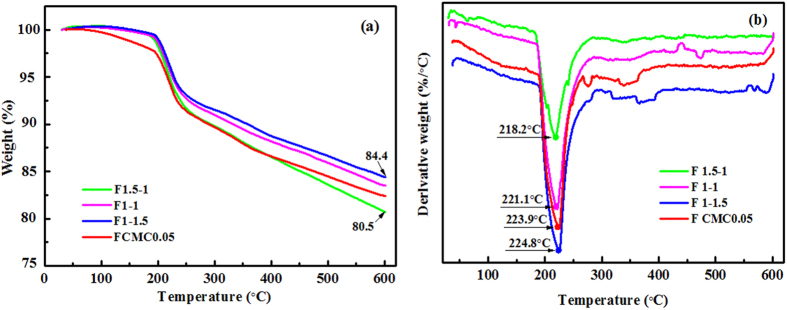
TGA (a) and DTG (b) curves of the representative films (F1.5-1, F1-1, F1-1.5, FCMC0.05).